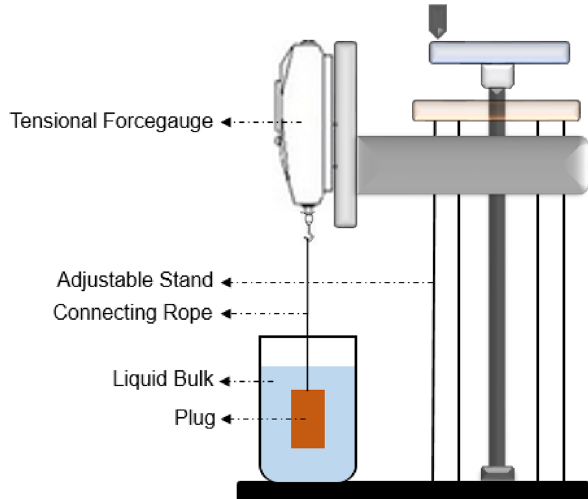
Fig. 5 Schematic of the liquid–gas imbibition system (Nowrouzi et